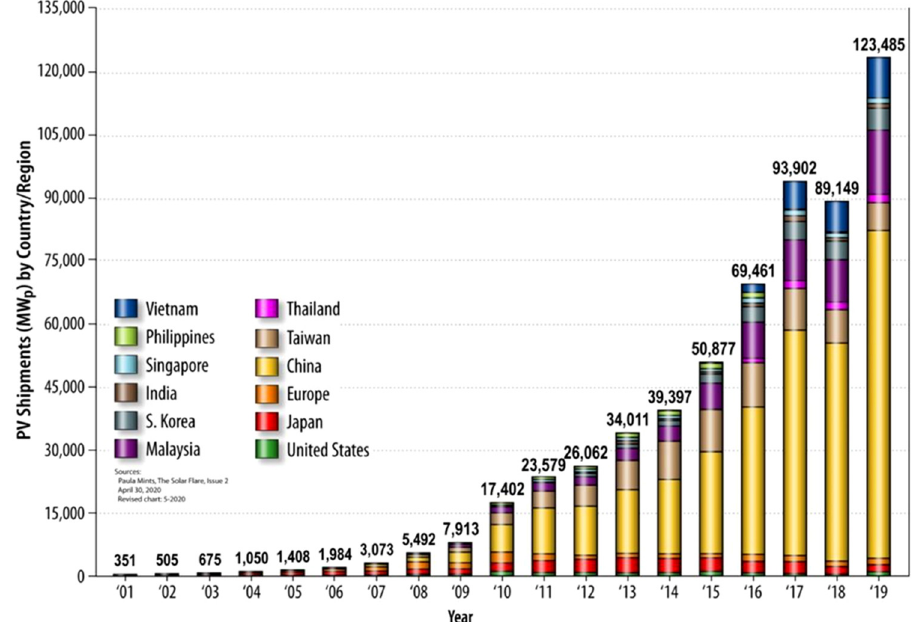
Fig. 20. PV Shipment 2019, World now has 583.5 GW of operational PV, 2020